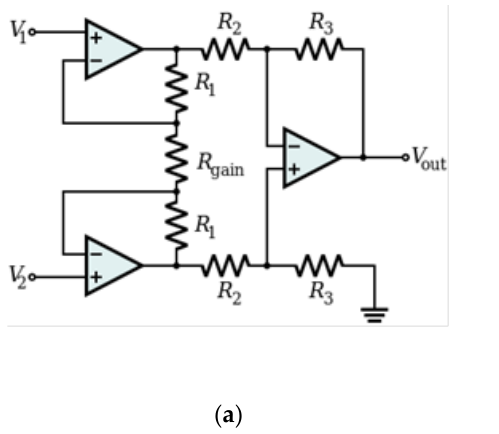
Figure 9. Instrumentation amplifier (IA): ( a ) circuit diagram of the IA; ( b ) layout diagram of single stage op-amp of the IA drawn in Cadence software.